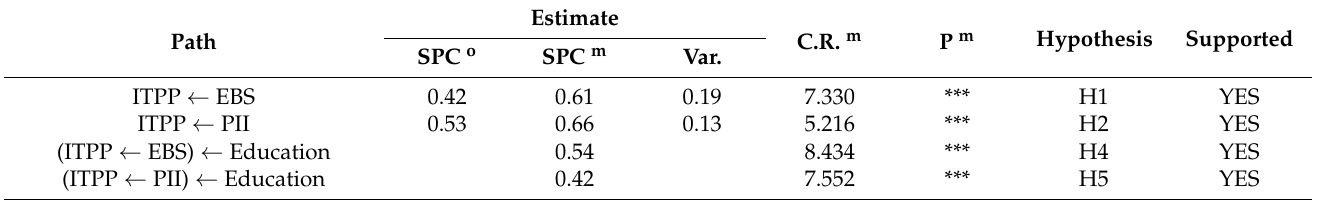
Table 6. Results of the SEM with moderator and hypothesis